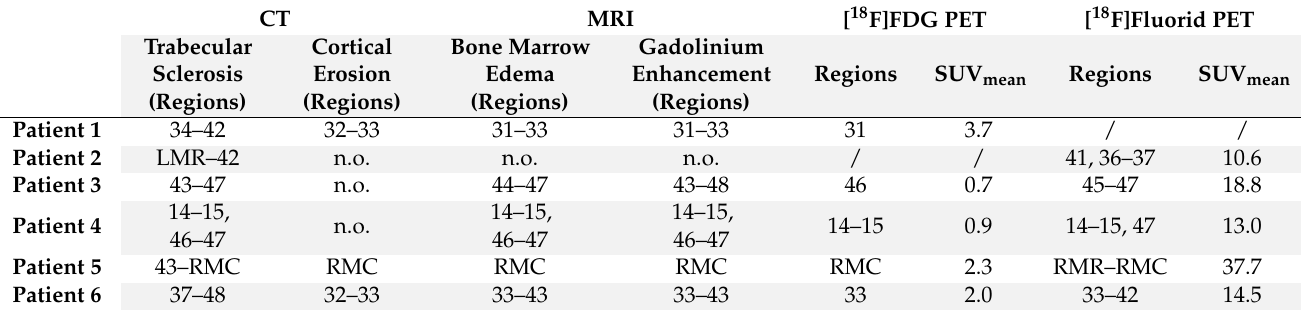
Table 1. Extent of OMJ depending on imaging modality.